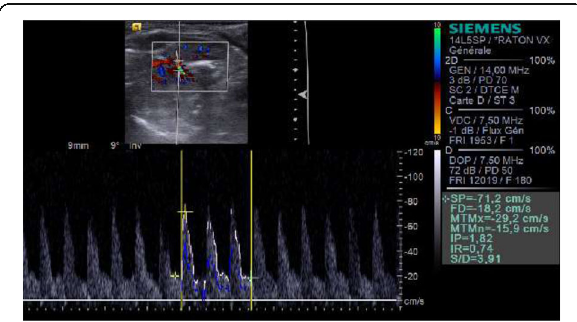
Fig. 1 (abstract 0009). A. Left renal artery pulsed Doppler in WT